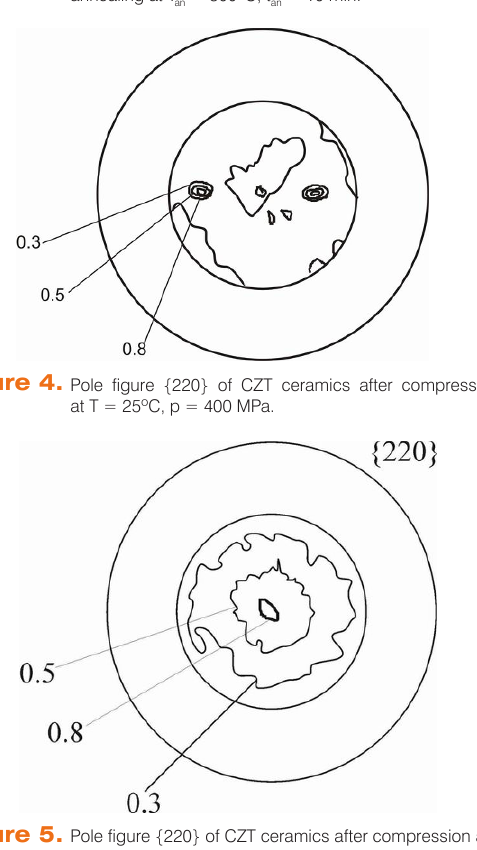
Figure 3. Cd-Zn-Te ceramics after compression at T = 25ºC, p = 400 MPa: (a, b) grain size distribution; (c, d) microstructure before and after annealing at T = 300ºC, t = 10 min. an an